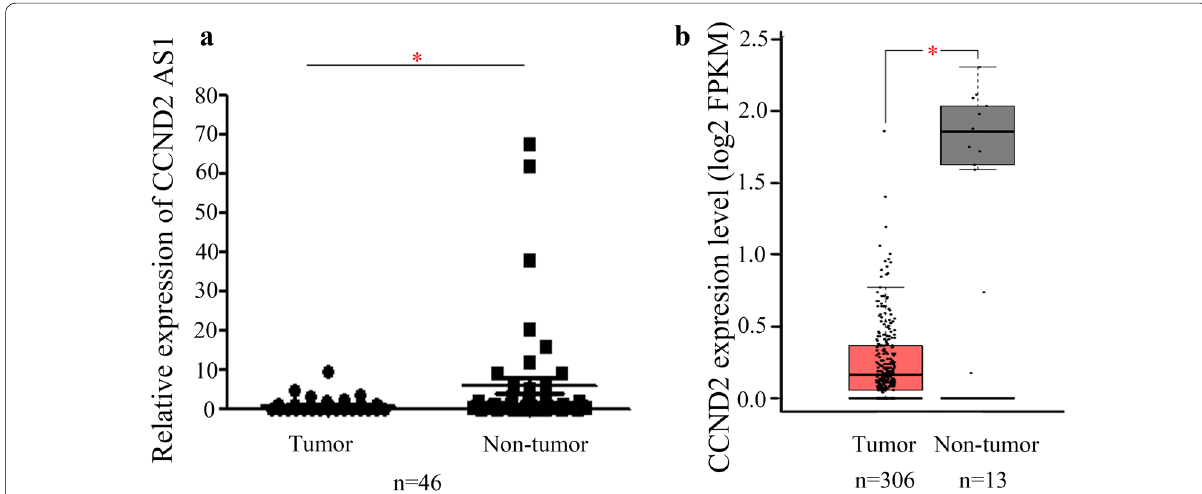
Fig. 1 Decreased expression of the long non-coding RNA CCND2 AS1 in cervical cancer tissues. a The expression of CCND2 AS1 was significant down-regulated in cervical cancer tissues compared with the corresponding adjacent non-tumors tissues (n AS1 was detected by qRT-PCR and GAPDH expression was used as a reference gene, the black lines are the mean expression of CCND2 AS1 was significant decreased in 306 cervical cancer tissues compared with 13 normal tissues, which was from the GEPIA database. * p < 0.05 (unpaired Student’s